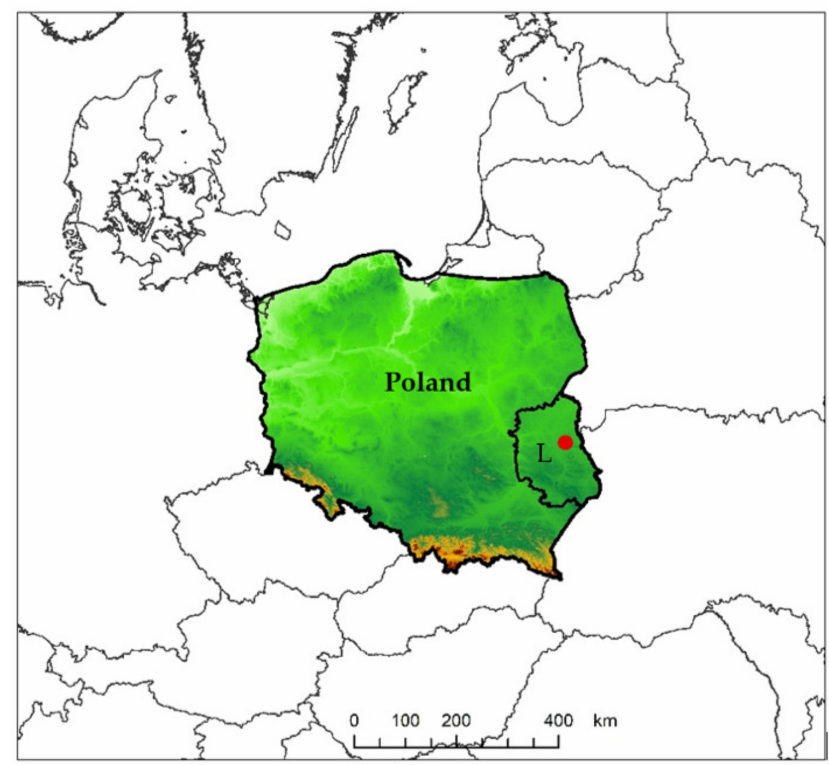
Figure 1. Research area in south-eastern Poland, L-Lublin